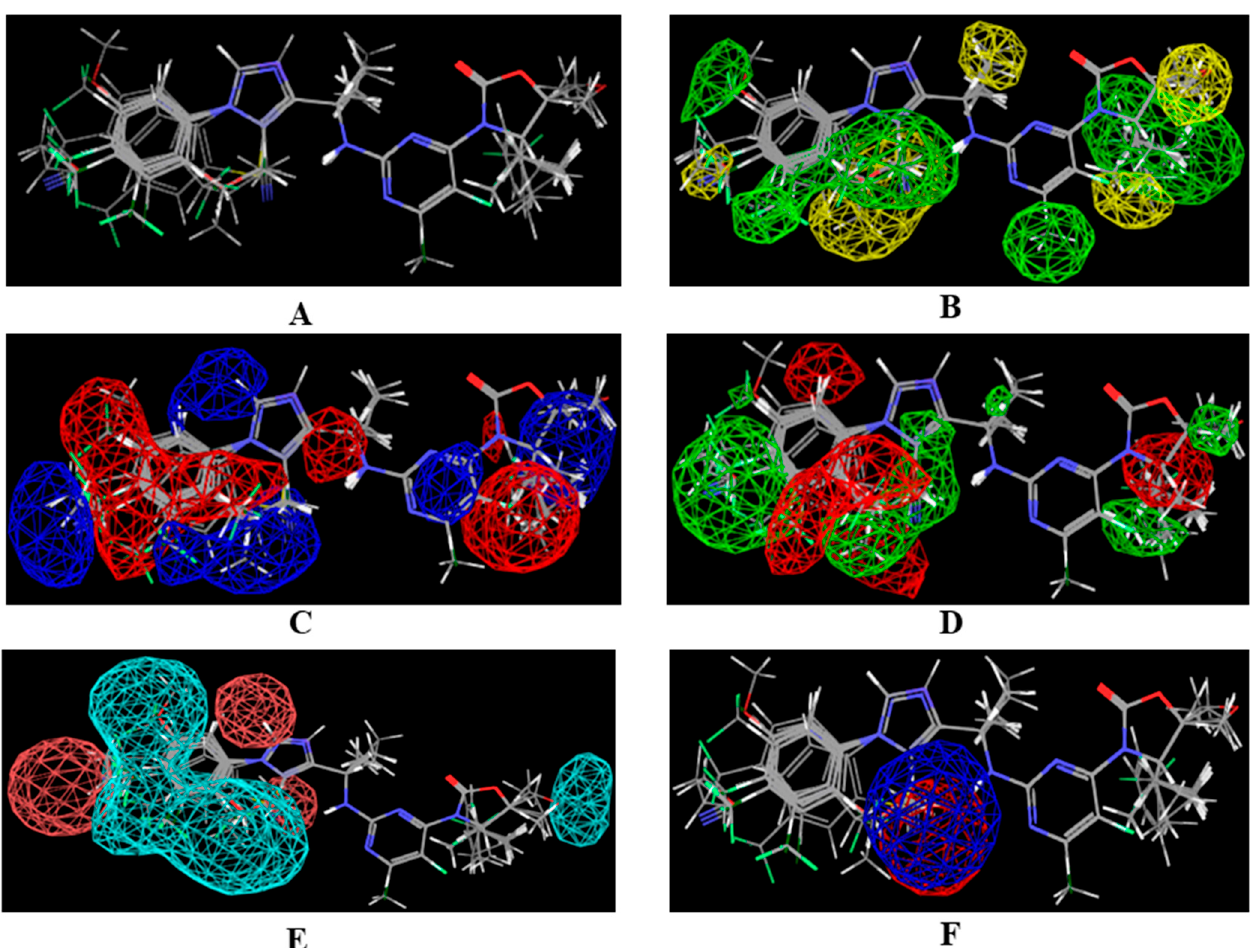
Figure 1. The aligned structures of ( A ) 62 reported ligands using Tanimoto similarities and the FB-3D-QSAR modeled results of favorable and unfavorable contour maps for ( B ) steric (Green—Positive, Yellow—Negative), ( C ) electrostatic (Blue—Positive, Red—Negative), ( D ) hydrophobic (Green—Positive, Red—Negative), ( E ) hydrogen bond acceptor (Cyan—Positive, Pink—Negative) and ( F ) donor (Blue—Positive, Red—Negative) properties.